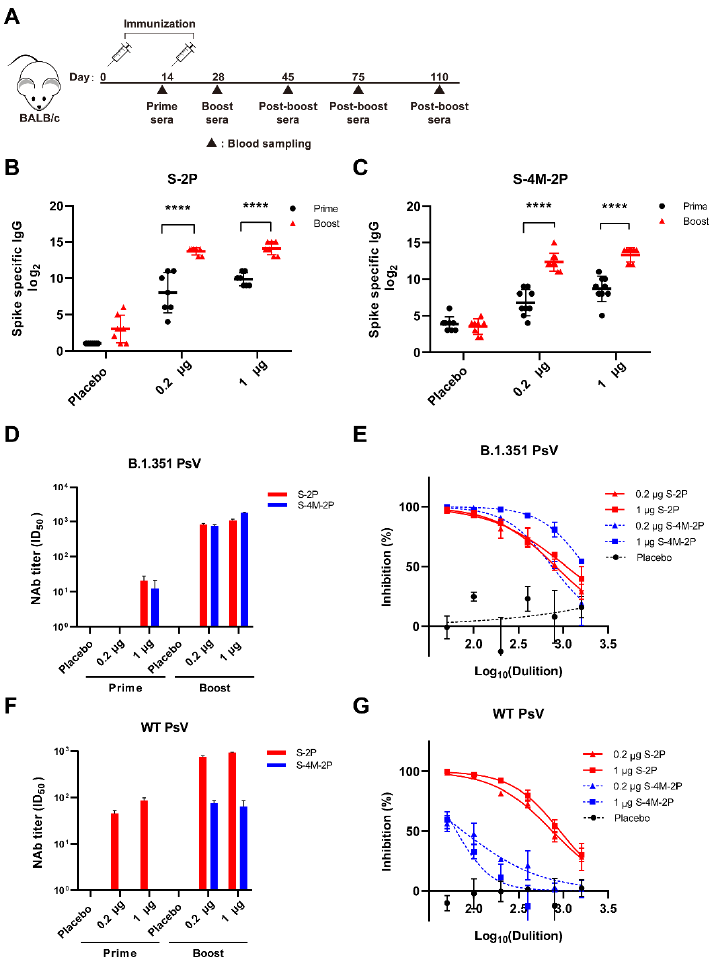
Figure 2. Immunogenicity of the WT SARS ‐ CoV ‐ 2 and variant spike proteins in mice. The prime ‐ boost regimen using spike proteins adjuvanted with aluminum hydroxide results in sera possessing neutralization activity. ( A ) Schematic diagram of prime ‐ boost vaccination strategy and sample col ‐ lection schedule. BALB/c mice were prime immunized i.m. with low ‐ dose (0.2 μ g, n = 8) or high ‐ dose (1 μ g, n = 8) spike proteins adjuvanted with aluminum hydroxide or adjuvant only (placebo group, n = 8) at day 0 and boosted with an equivalent dose 14 days later. Sera were collected at the indicated time points for further assays. SARS ‐ CoV ‐ 2 spike ‐ specific IgG titers of sera from S ‐ 2P ‐ immunized mice ( B ) and S ‐ 4M ‐ 2P ‐ immunized mice ( C ) were determined by ELISA. The sera from each group collected at the same time were mixed together in equal quantities, and pseudovirus ‐ based neutralization assays were performed to detect neutralizing antibody (NAb) titers (ID 50 ) of prime and boost sera from S ‐ 2P ‐ or S ‐ 4M ‐ 2P ‐ immunized mice against WT SARS ‐ CoV ‐ 2 spike ( D ) or B.1.351 variant spike ( E ) pseudovirus. Data are shown as mean ± SEM, representative of two inde ‐ pendent experiments with two replicates. Representative neutralization curves of boost sera from S ‐ 2P ‐ or S ‐ 4M ‐ 2P ‐ immunized mice against WT SARS ‐ CoV ‐ 2 spike ( F ) or B.1.351 variant spike ( G ) pseudovirus. PsV, pseudovirus. The log 10 ‐ transformed dilutions of the sera are shown against the percentage of neutralization. **** p < 0.0001.